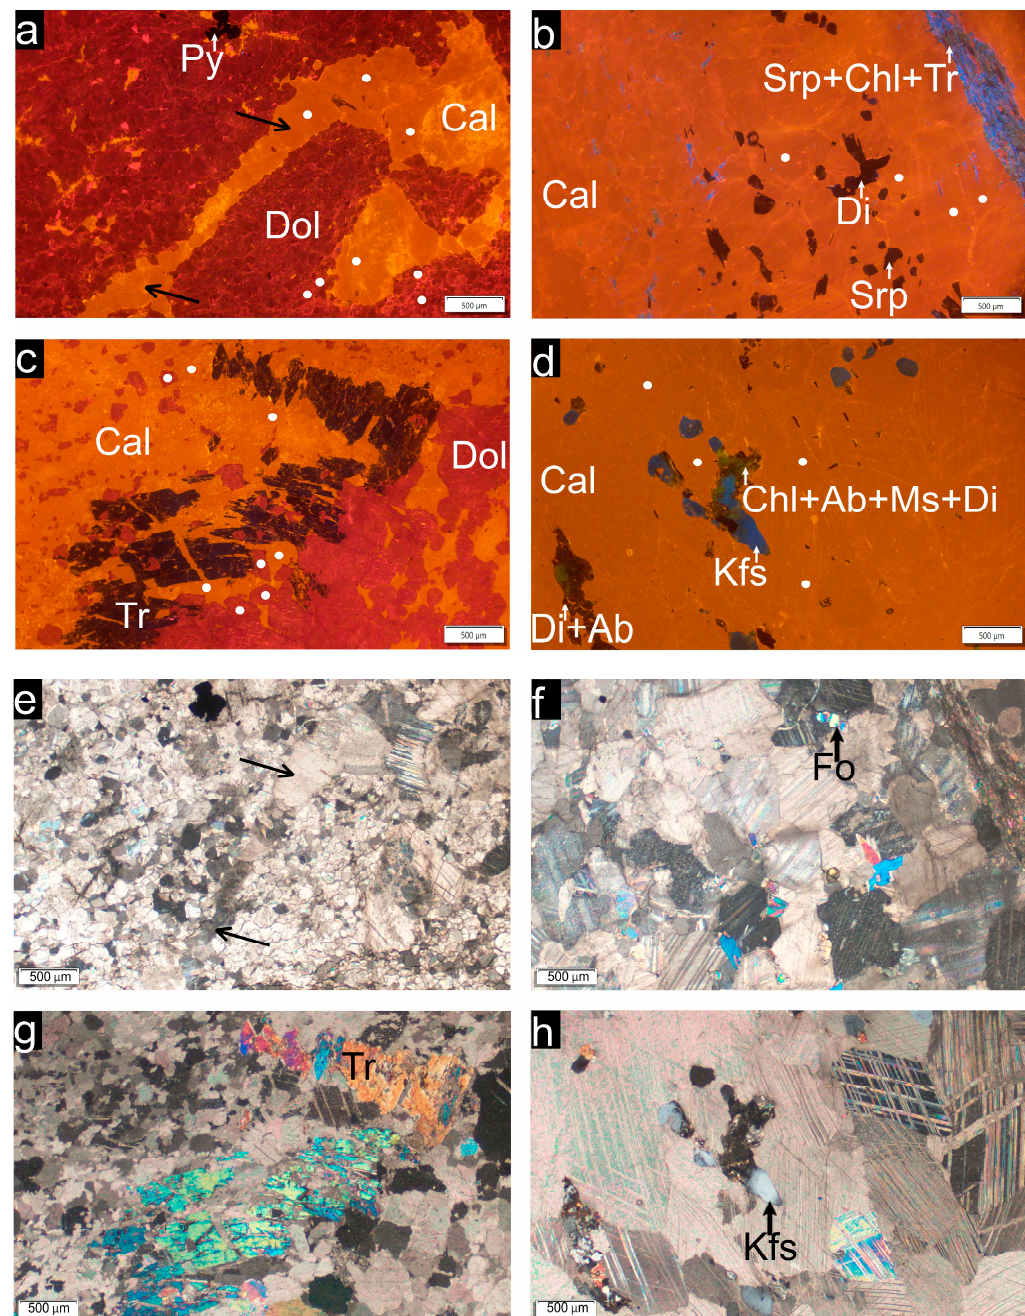
Figure 1. CL-microphotographs of the studied marbles obtained by cold-stage CL (CL8200 Mk4) ( a – d ) and microphotographs in crossed nicols of the same area as in CL obtained by polarizing microscope (Leica DMPL) ( e – h ). ( a , e ) Dolomitic marble from Raspenava with secondary calcite veins (veinlets are highlighted by black arrows) (sample No. 174); ( b , f ) calcitic type of dolomitic marble from Raspenava with higher amount of non-carbonate phases (sample No. 174); ( c , g ) dolomitic marble from Bohdane č (sample No. 227); ( d , h ) calcitic marble from Nedv ě dice (sample No. 288). The white dots represent areas where the CL-spectra were measured (by xCLent spectroscopy at the JEOL hyperprobe). Abbreviations: Ab albite, Cal-calcite, Fo-forsterite, Chl-chlorite, Di-diopside, Dol-dolomite, Kfs-K-feldspar, Ms-muscovite, Py-pyrite, Srp-serpentine minerals (antigorite replacing forsterite grains, and chrysotile in bands), Tr-tremolite.